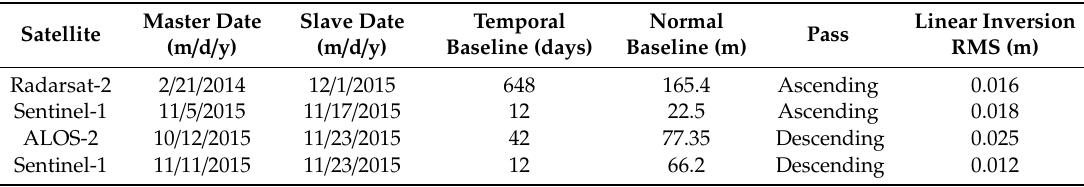
Table 1. Radar data used.